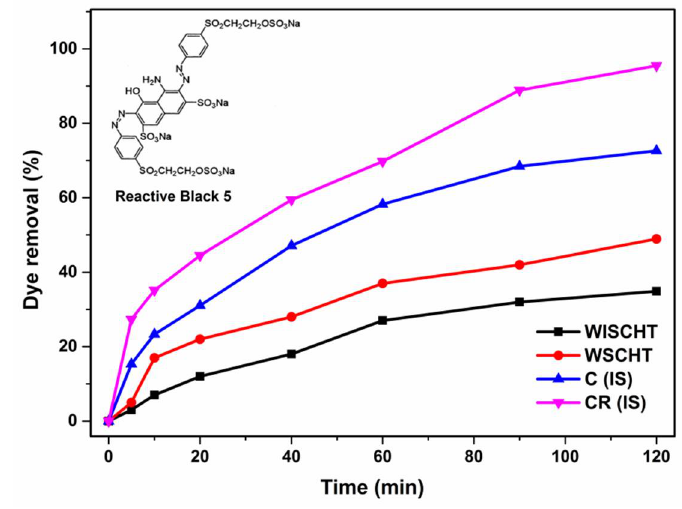
Figure 11. The effect of adsorption time on dye removal by prepared nanofibers and powders.